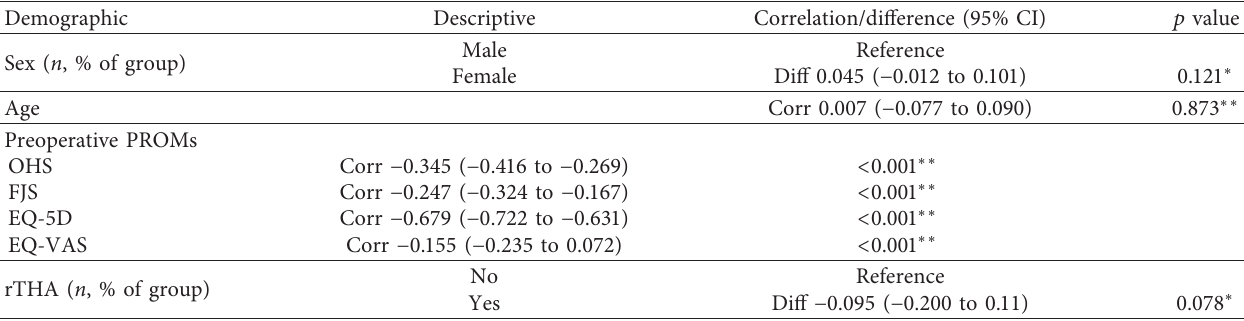
Table 3: Change in the EQ-5D score according to patient demographics, preoperative functional scores, and type of total hip arthroplasty (robotic arm-assisted versus non-robotic arm-assisted).